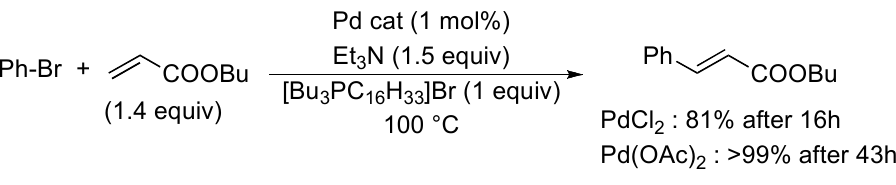
Scheme 1. Heck reaction without additive ligands in [C